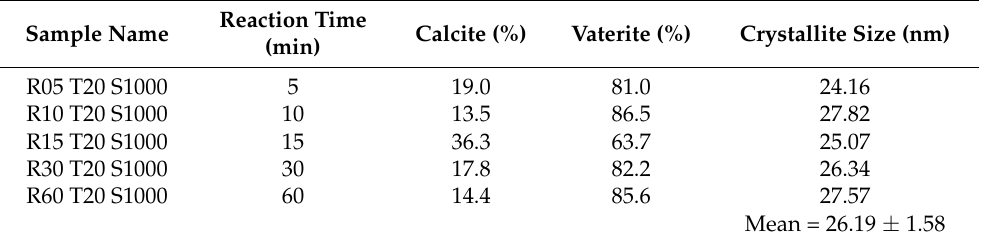
Table 3. Effect of reaction time on the as-prepared CaCO 3 polymorph ratio and size of crystallite (at a temperature of 20 ◦ C and stirring speed of 1000